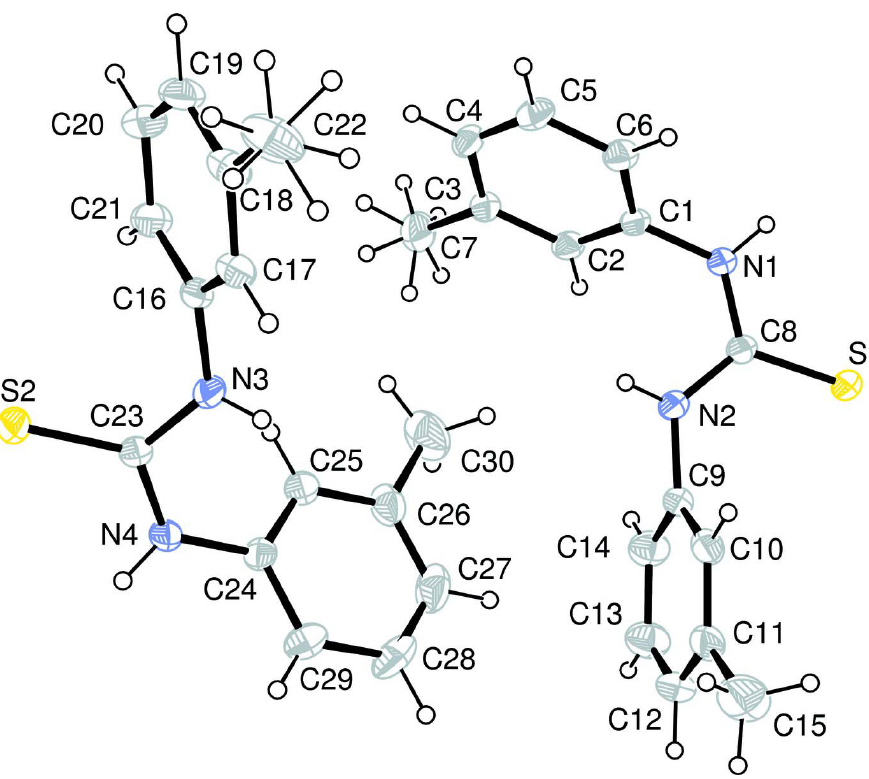
Figure 1 ORTEP drawing of the title compound with the atom numbering scheme. The thermal ellipsoids are drawn at the 30% probability level. H atoms are shown by small circles of arbitrary